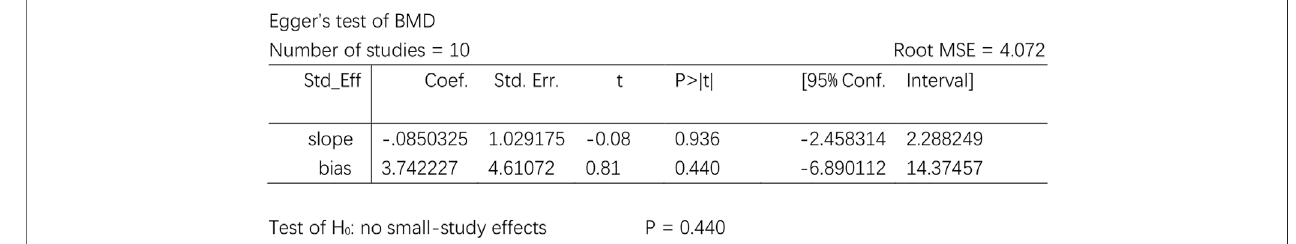
FIGURE 10 | The publication bias